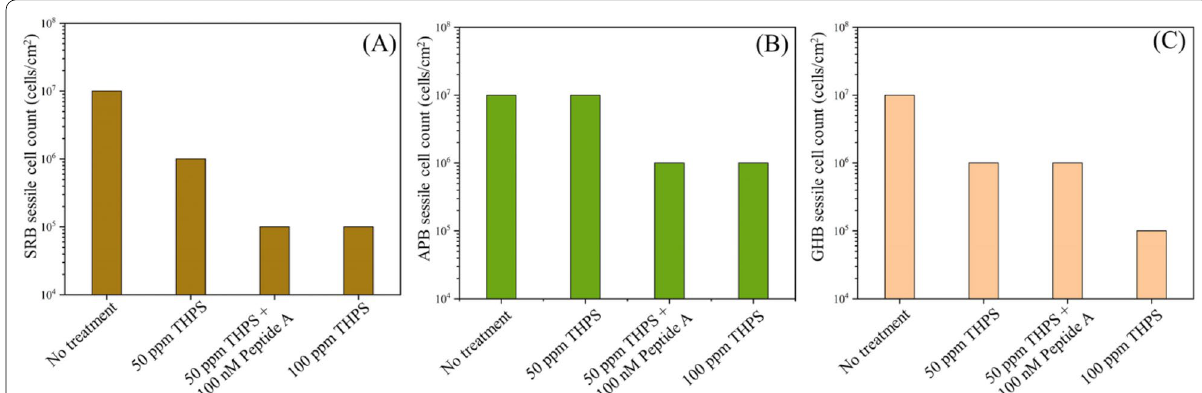
Fig. 5 Sessile cell counts of A SRB, B APB and C GHB in flow loop bioreactors after 7-day biofilm prevention test with different biocide treatments